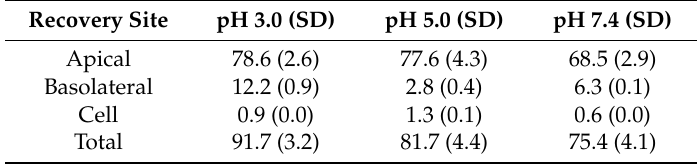
Table 1. Average % anthocyanin recovery (SD: standard deviation) from apical, basolateral, and cell layers at varying apical pH values after 3 h treatment at 37 ◦ C with initial anthocyanin concentration of 1500 µ